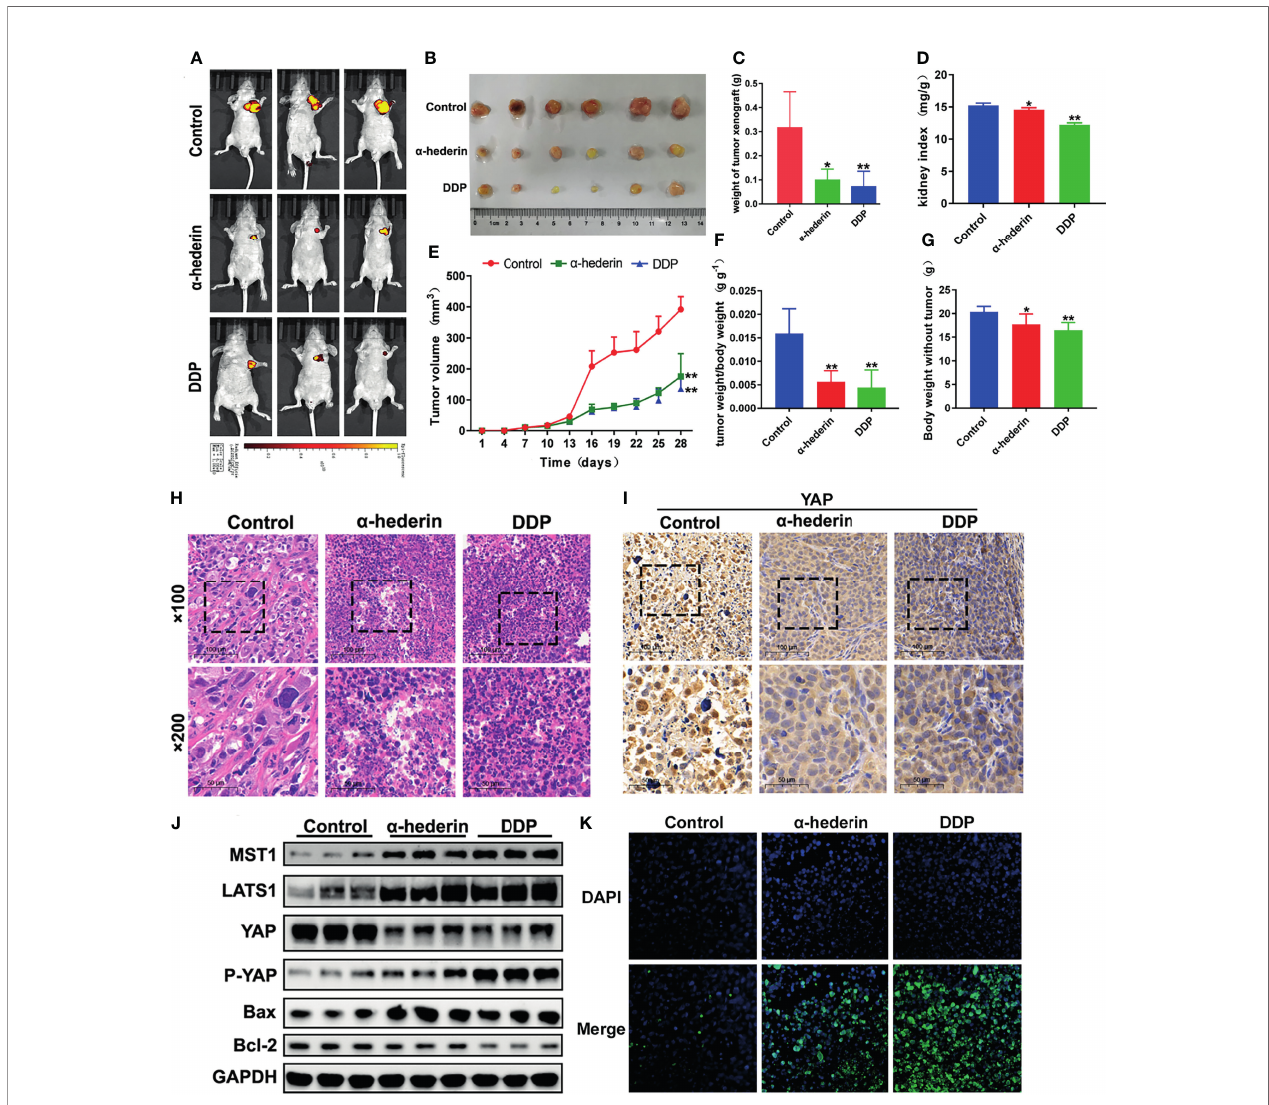
FIGURE 6 | a -hederin attenuated xenograft HCC tumor growth in vivo through inhibiting YAP signaling pathway. (A) In vivo imaging of the HepG2 cell xenograft model mice. (B) Representative images of tumors collected from HepG2 cell xenograft model mice treated with PBS, a -hederin and DDP. (C) Weight of xenograft tumors harvested from mice. (D) Kidney index (kidney weight/bodyweight). (E) Tumor volumes were measured at different time points. (F) The ratio of tumor weight/body weight. (G) Mice body weight subtracted tumor at the end point. (H) HE staining of representative tumor tissues from different groups. (I) Immunohistochemistry analysis of YAP in mouse tumor tissues. (J) Immunoblot analysis of Hippo-YAP signaling pathway-related proteins and apoptosis-related proteins in the tumor tissues. (K) TUNEL staining of tumor tissues. Signi fi cance: * p < 0.05 versus control, ** p < 0.01 versus